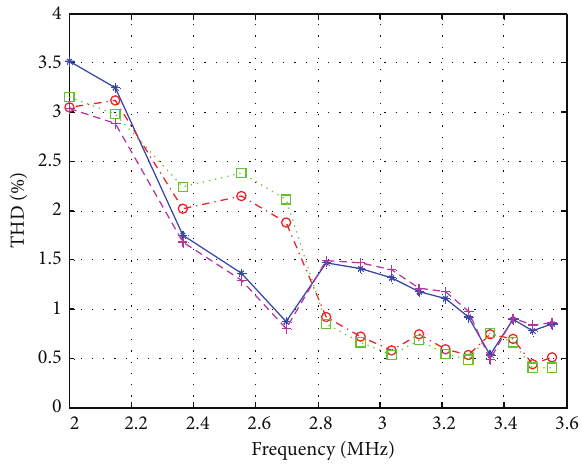
Figure 14: Total harmonic distortion (THD) as a function of oscillation frequency (blue: 𝑉 𝑜1 ; red: 𝑉 𝑜2 ; pink: 𝐼 𝑜1 ; and green: 𝐼 𝑜2 ).